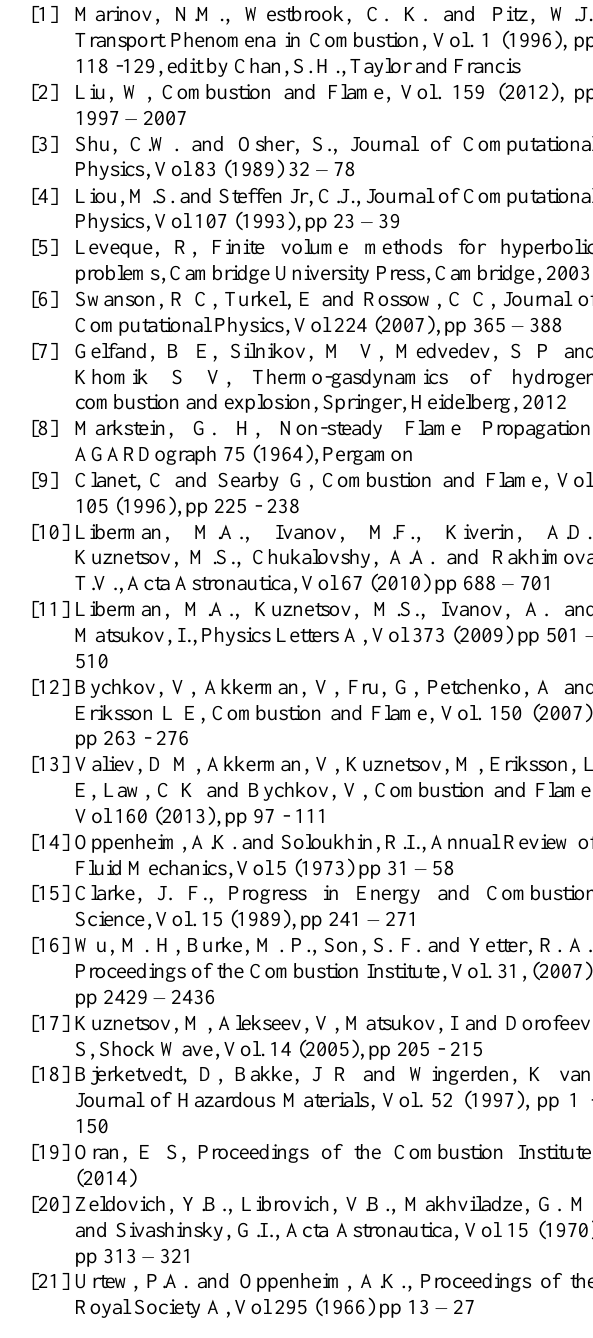
zone of the shock waves there is no chemical